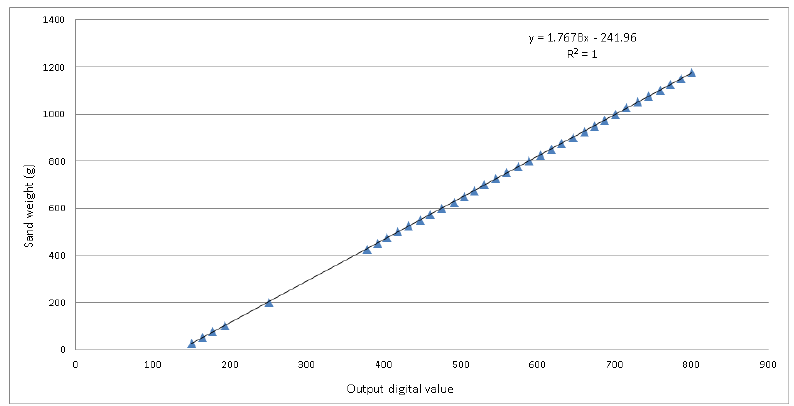
Figure 5. Linear regression of the acquired values. R 2 = 1 means that the regressors predict accurately the value of the sand weight using the output digital